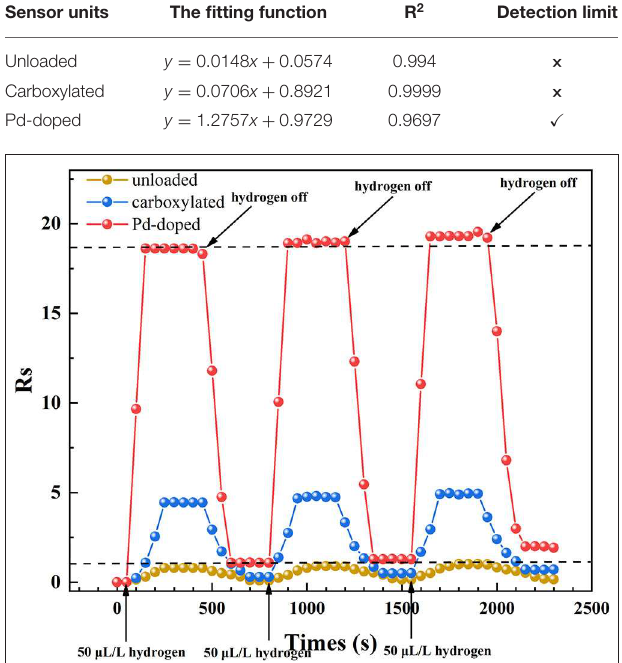
TABLE 1 | The fitting function, linearity and detecting limitation of three SWCNTs-based gas sensors to hydrogen. Sensor units